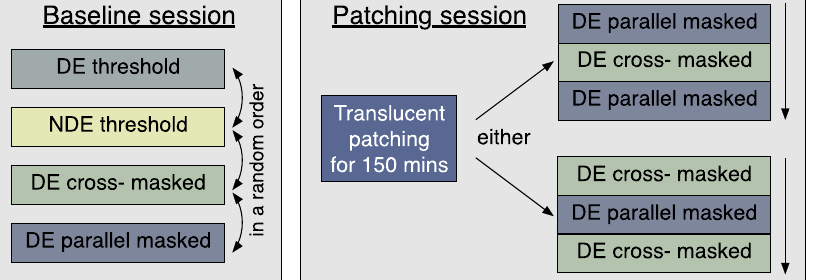
Figure 5. Sequence of conditions tested for the baseline and patching sessions. In the baseline sessions, the subjects were tested once on each condition in a random order. For the patching sessions, the subjects were tested on one of two fixed sequences of